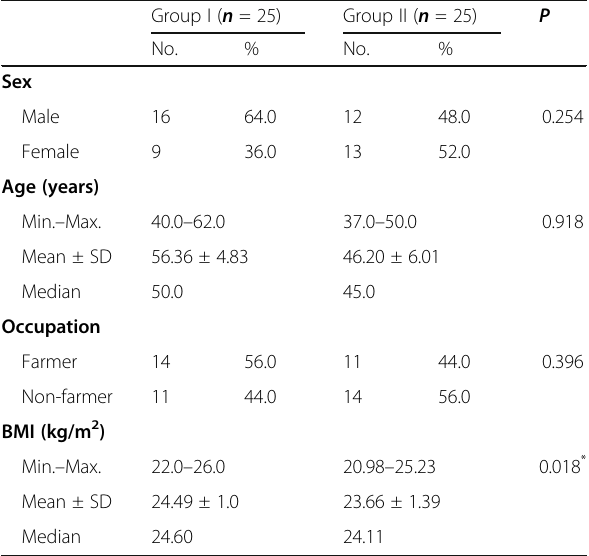
Table 1 Comparison between the two studied groups according to their demographic